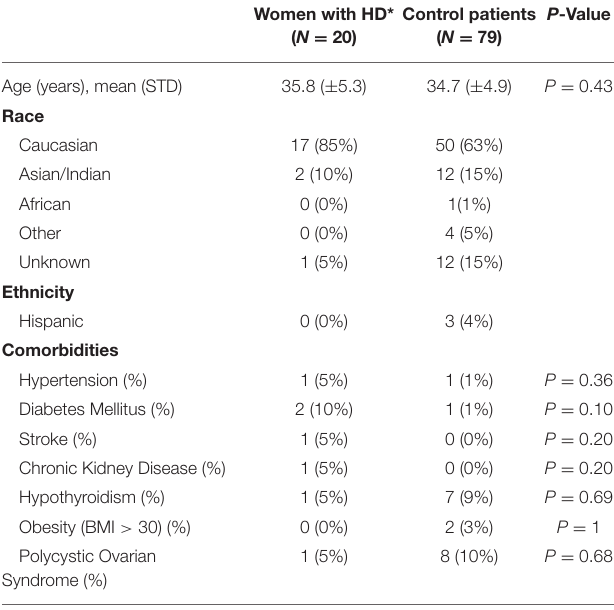
TABLE 1 | Baseline characteristics of women with HD and